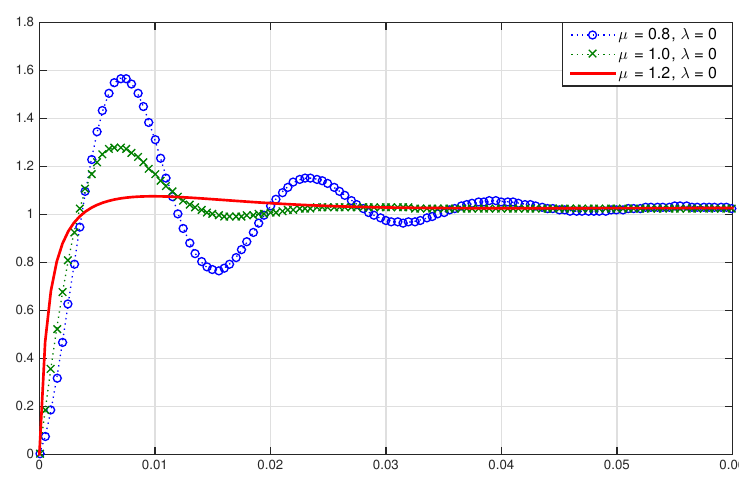
Figure 6. Time domain effects of the derivative gain.